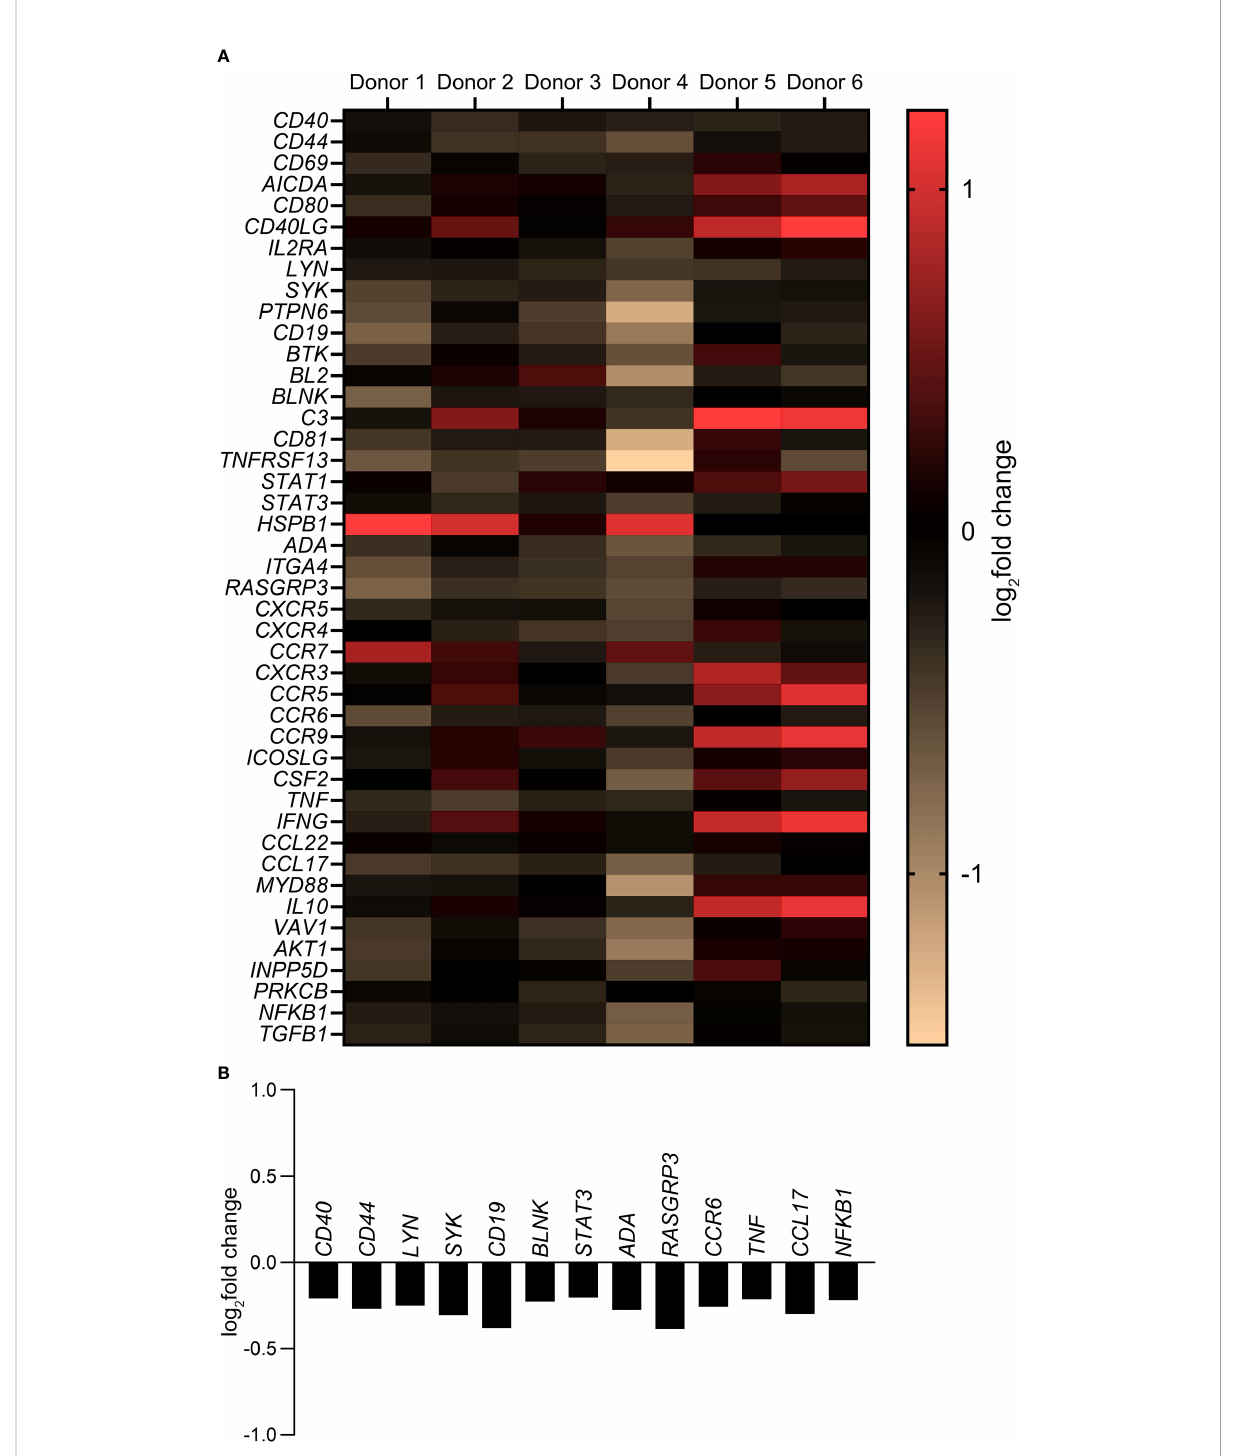
FIGURE 5 Gene expression pro fi le of B cells after treatment with MMP-3. (A) Expression of B cell-related genes by pre-stimulated B cells treated with activated rMMP-3 relative to APMA in different donors ( n = 6). B cells from 8 – 10 wells/condition/donor were pooled and measurements were done in duplicates. Values show the log 2 fold change. (B) The graph represents the log 2 fold change of signi fi cantly downregulated genes after MMP-3 treatment compared to the vehicle-treated group ( p < 0.05) using paired t